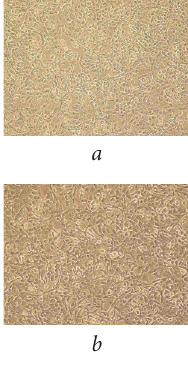
Fig. 1. bEnd.3 at 12 hours after SS2 infection: a – cell with SS2 infection; b – control